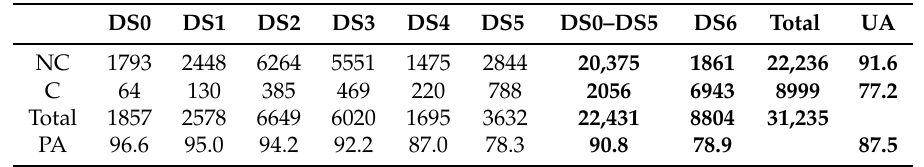
Table 2. Accuracy evaluation of the classification results for collapsed and non-collapsed buildings obtained using a linear discriminant function based on the fragility function of Suppasri et al. [28].